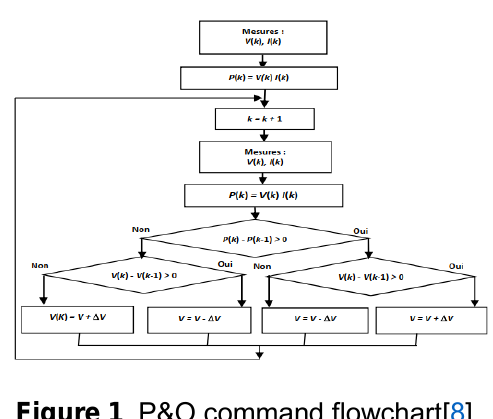
Figure 1 . P&O command flowchart[8].